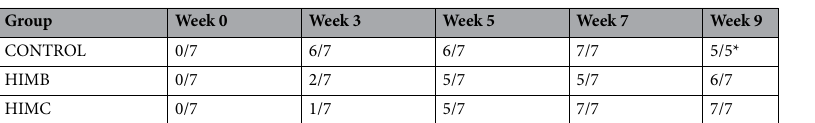
Table 1. Number of animals with clinical signs after M. caprae challenge in each treatment group (N = 7). *At week 7, two animals from the control group were humanely euthanized.